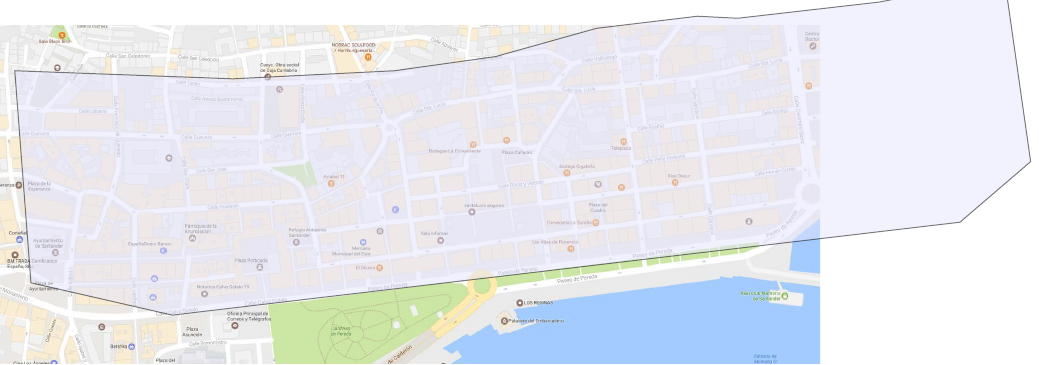
Figure 3. Target scenario in the downtown of Santander city.